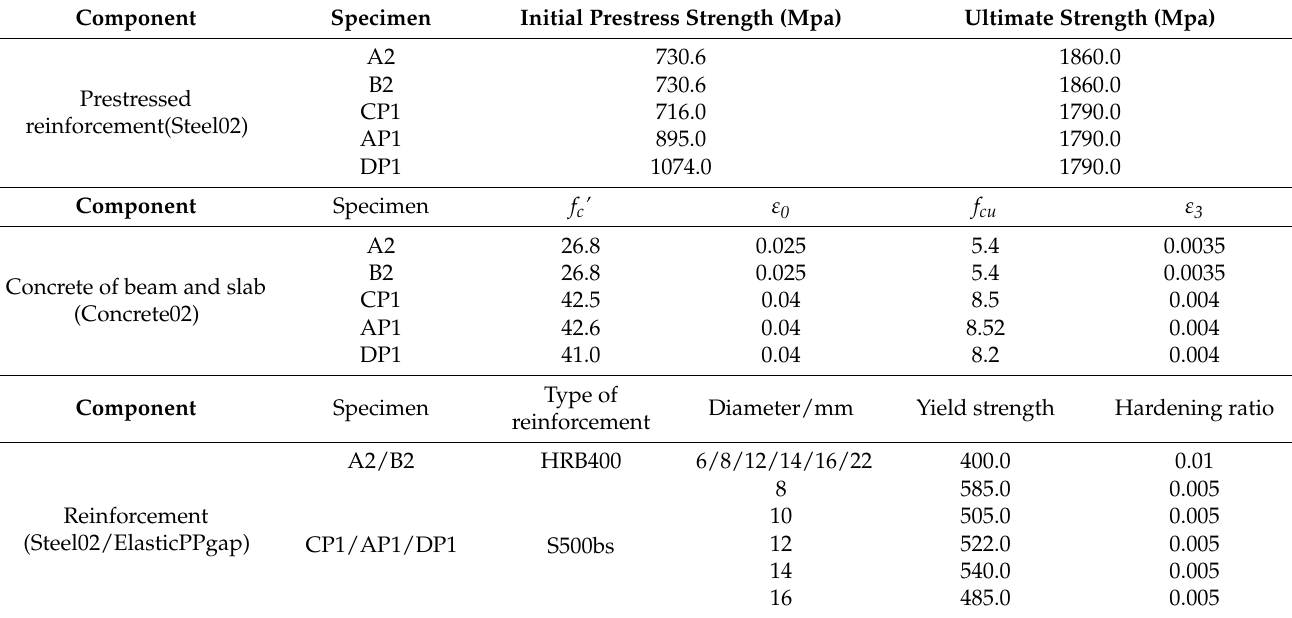
Table 1. Key parameters adopted in numerical